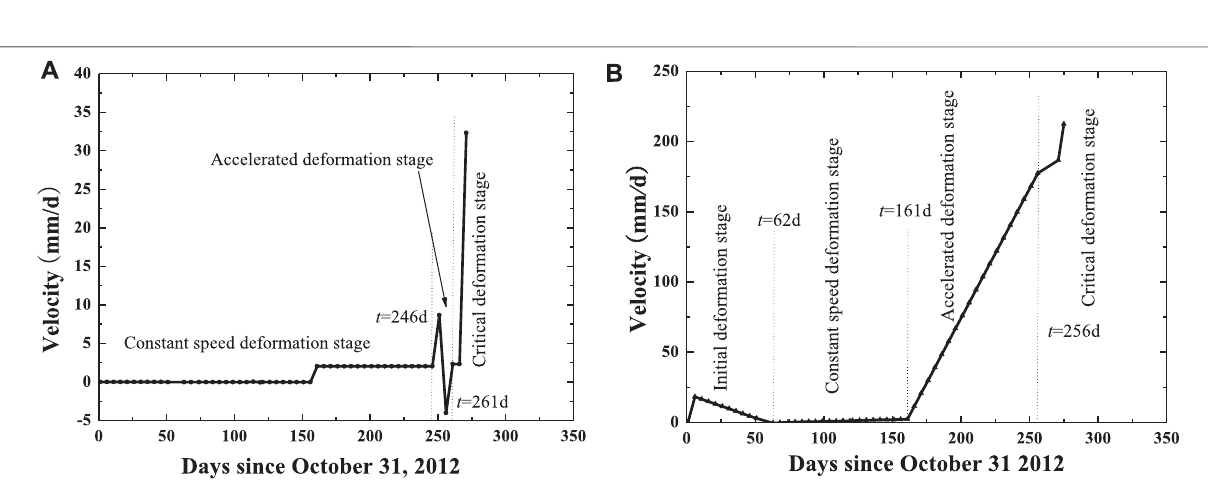
Frontiers in Earth Science |